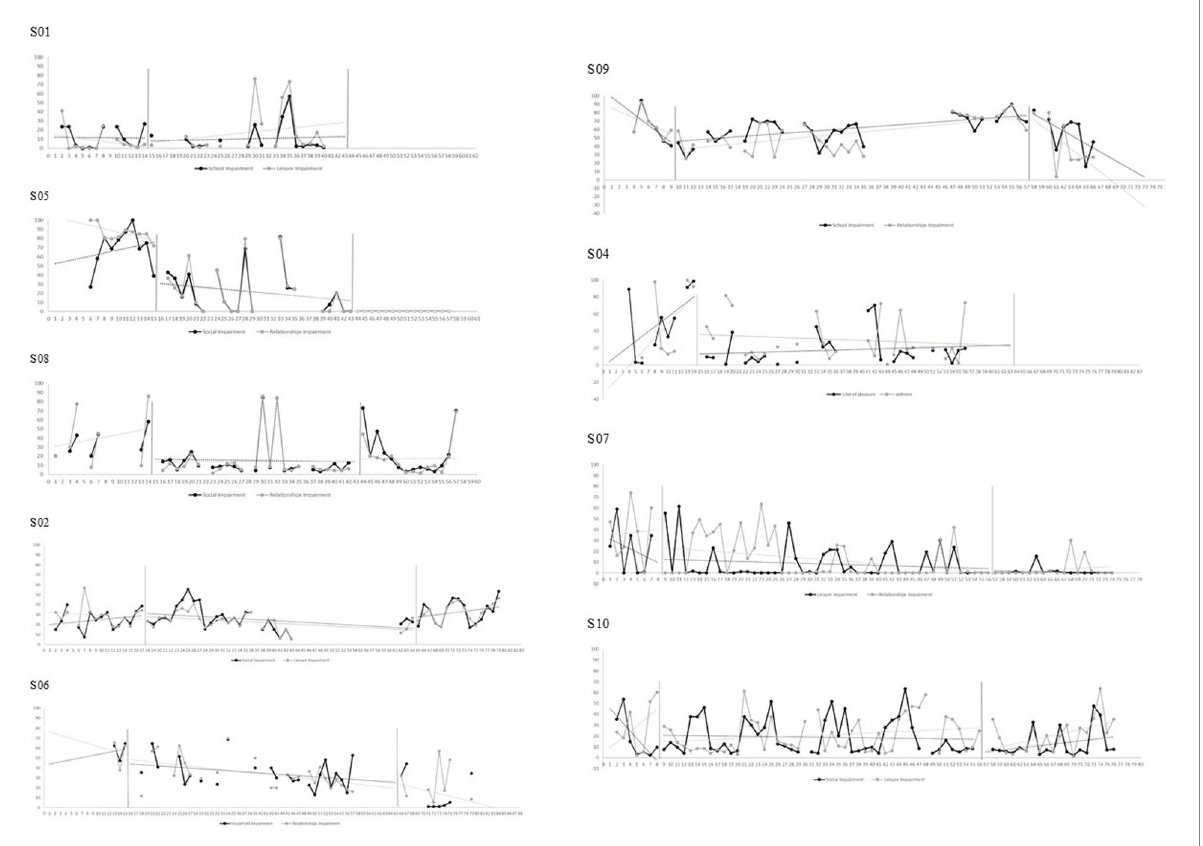
FIGURE 4 Raw data and trend for participants’ functioning impairment